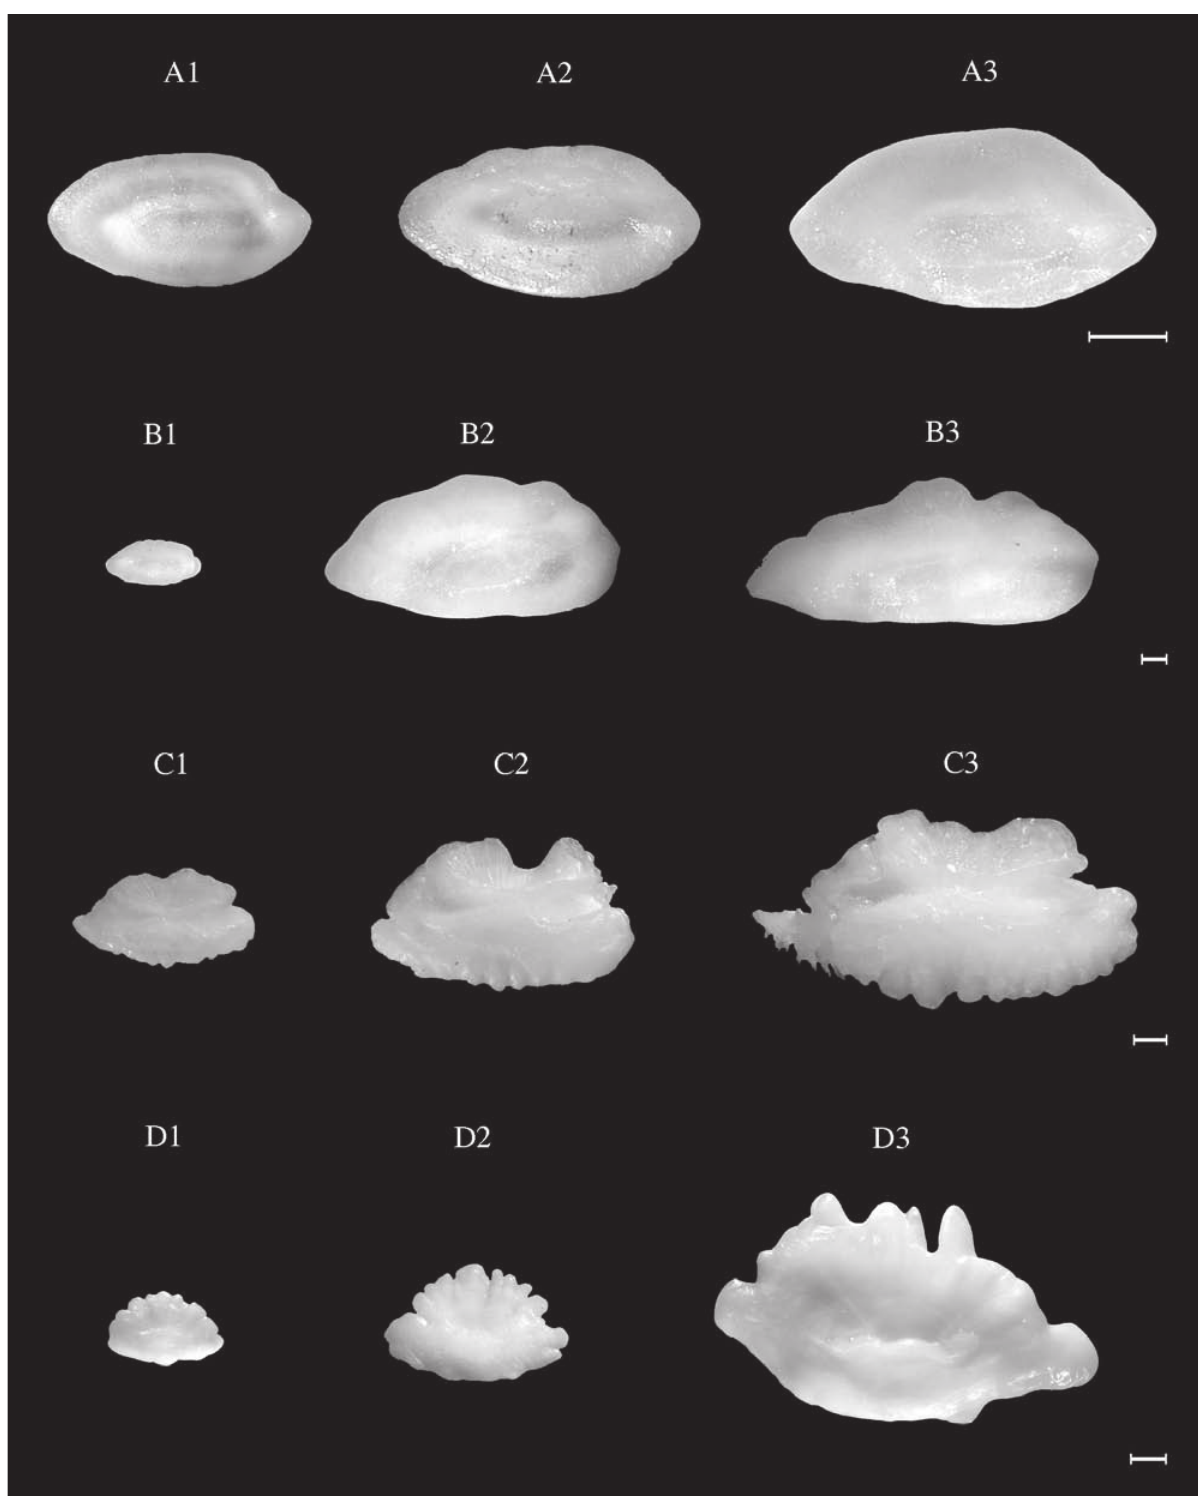
Fig. 34. – Cataetyx alleni (WM). TL: A1, 7.5 cm; A2, 9.0 cm; A3, 10.5 cm. Cataetyx laticeps (WM). TL: B1, 9.0 cm; B2, 34.5 cm; B3, 48.5 cm. Halobatrachus didactylus (NEA). TL: C1, 15.0 cm; C2, 30.2 cm; C3, 47.2 cm. Lophius budegassa . TL: D1, 11.0 cm (WM); D2, 21.1 cm (NEA); D3, 57.0 cm (WM). Scale bar = 1